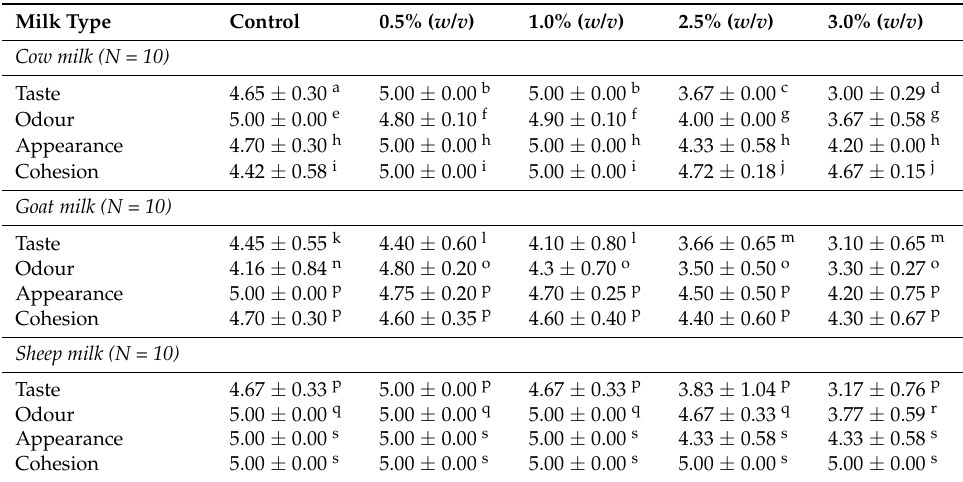
Table 4. Sensory evaluation of bee pollen enriched